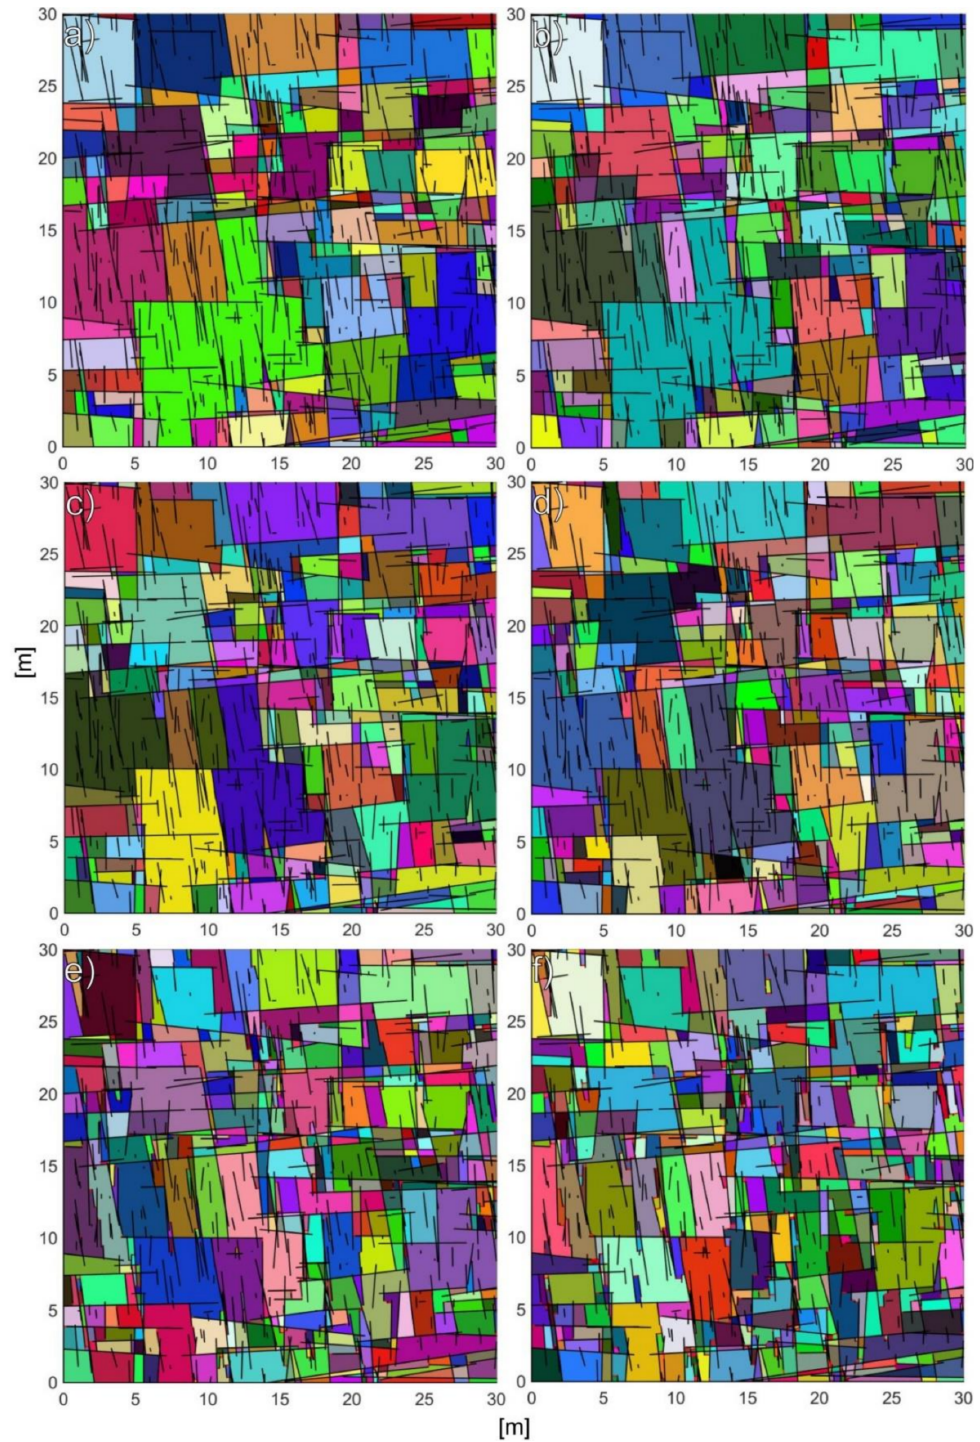
Figure 6. 2D discrete fracture networks showing 30 × 30 m detail views, extracted out of the 50 × 50 m total models. Areas generated by intersecting fracture traces (black lines) are shown and randomly colored. All models ( a – f ) are characterized by the same fracture network but varied regarding the threshold lengths for rock bridge